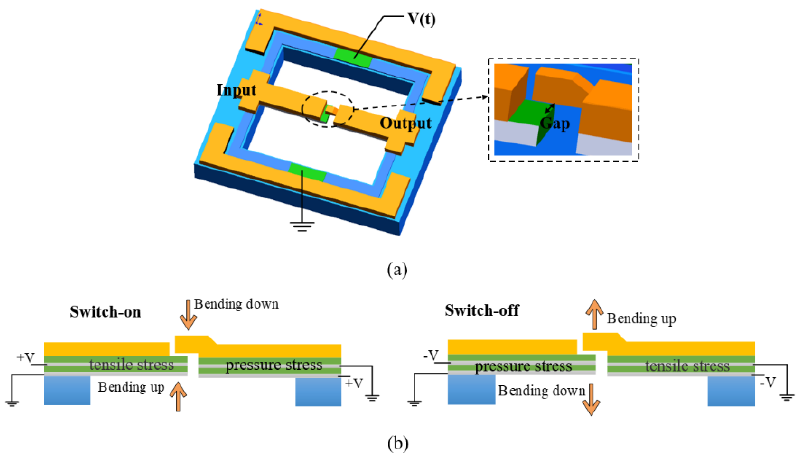
Figure 9. The piezoelectric AlN RF MEMS switches of dual-beam actuation proposed by